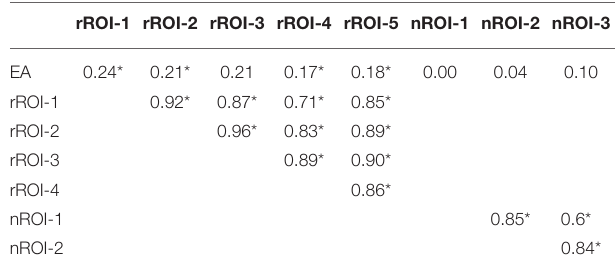
TABLE 2 | Pearson correlations between some of the studied variables: elbow angle (EA), raw (r) pixel intensity of subtrochlear regions of interest (ROIs) 1, 2, 3, 4 (cortex) and 5 (medulla), and normalized (n) subtrochlear nROI-1, 2, and